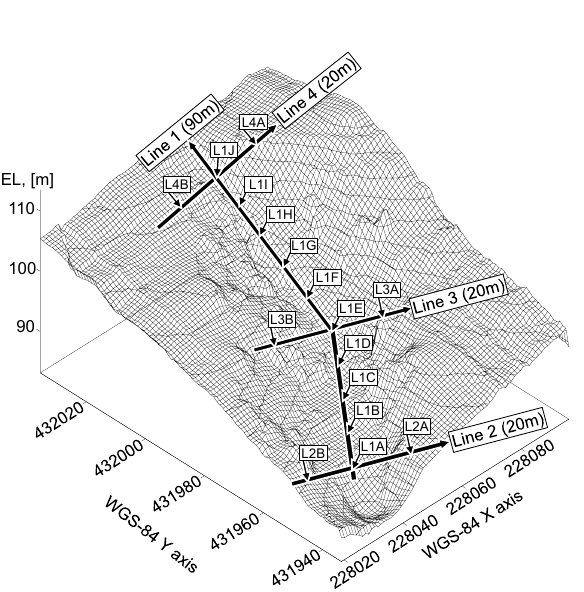
Figure 3. Experimental profiles. Lines 1, 2, 3, and 4 denote seismic and resistivity survey profiles. Arrows show points for performing penetration tests and extracting soil; arrow interval is 10 m. The only grid was built from software of Surfer. WGS: World Geodetic